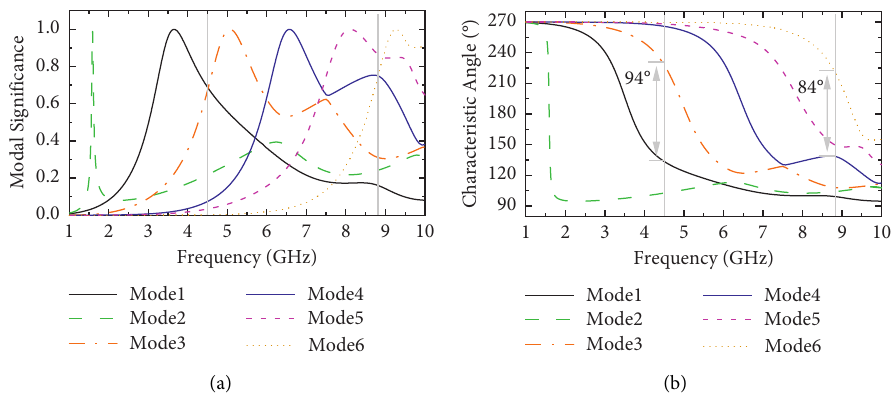
Figure 3: (a) Modal significance and (b) characteristic angle for the first six modes of radiator at 3